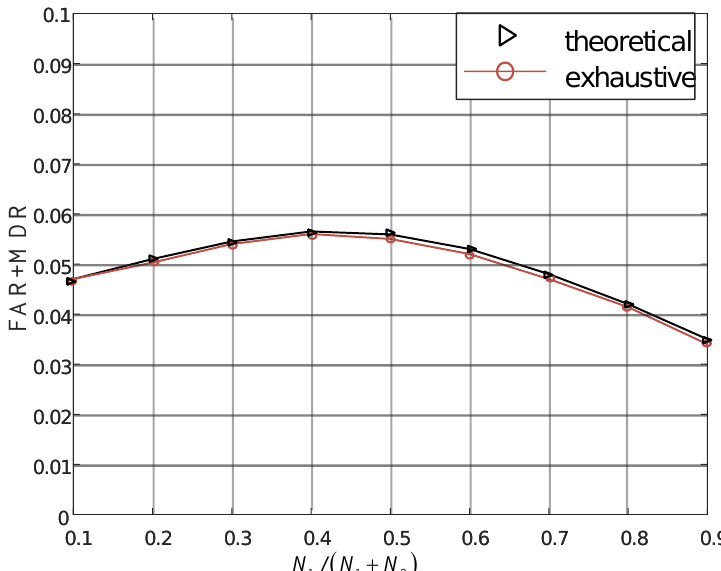
Figure 7. Optimal threshold